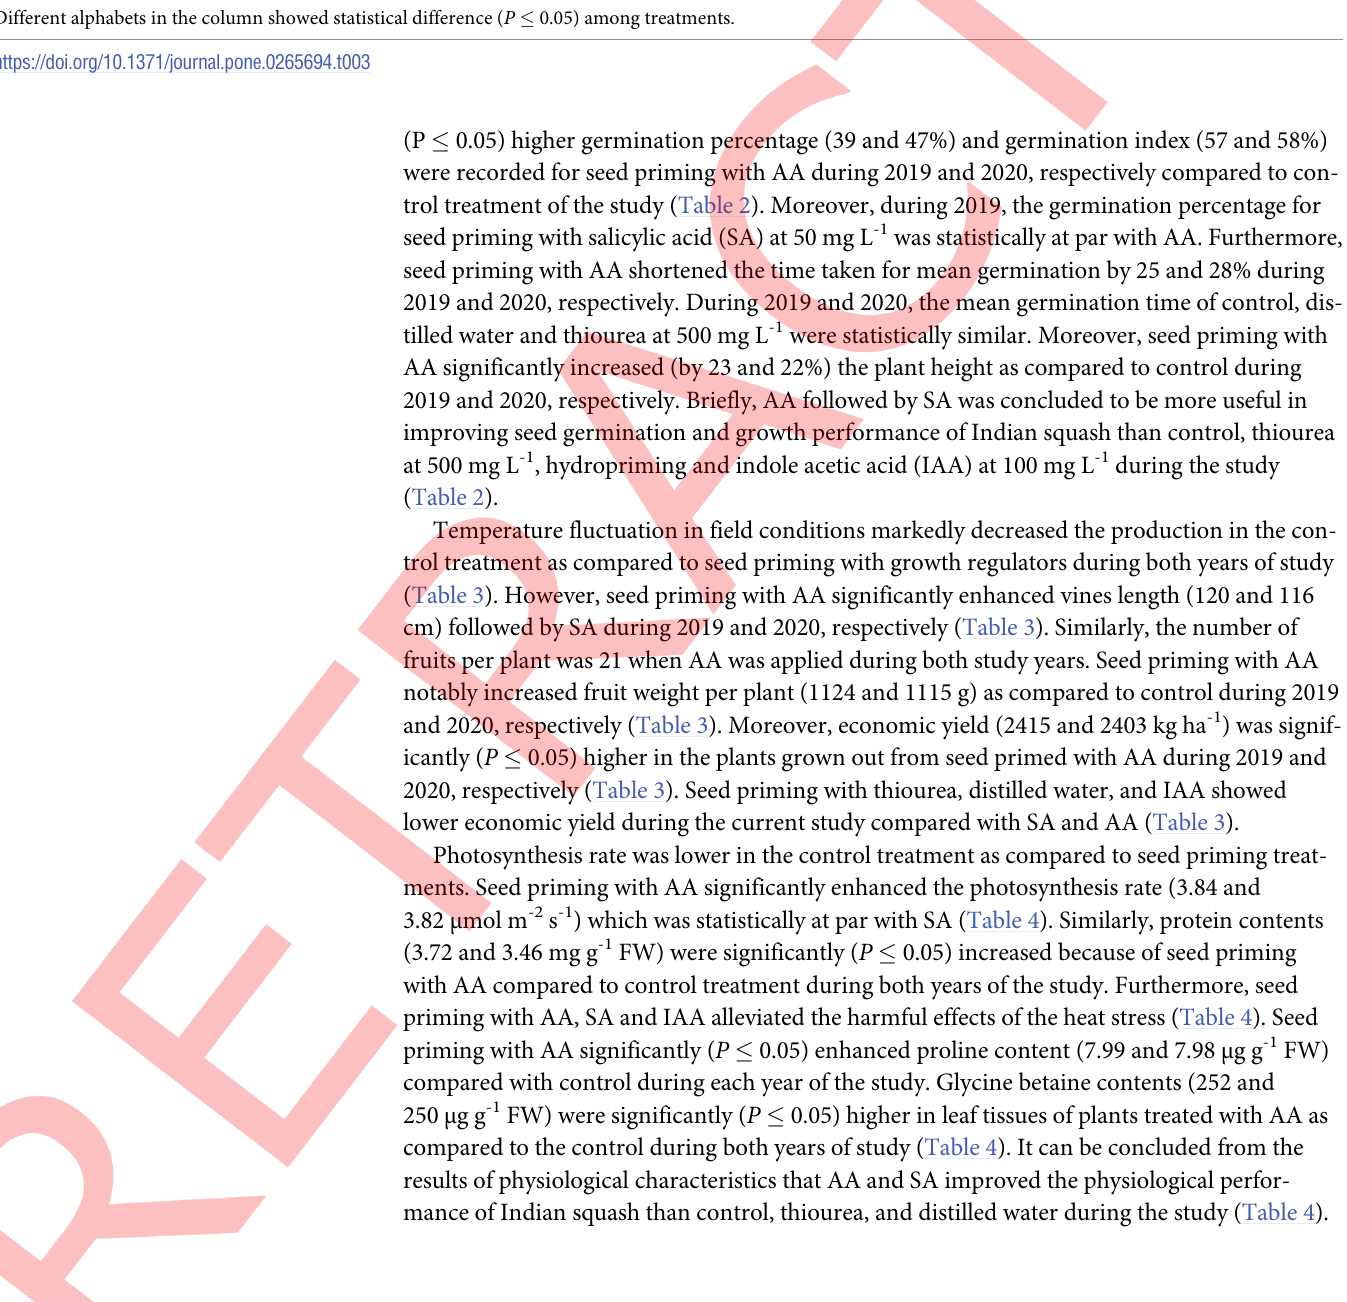
Different alphabets in the column showed statistical difference ( P � 0.05) among